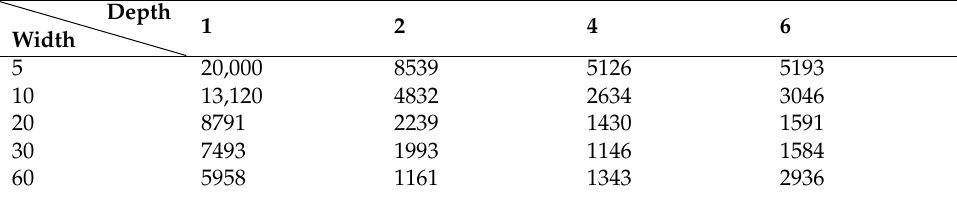
Table 2. The practical epoch for different neural network sizes.